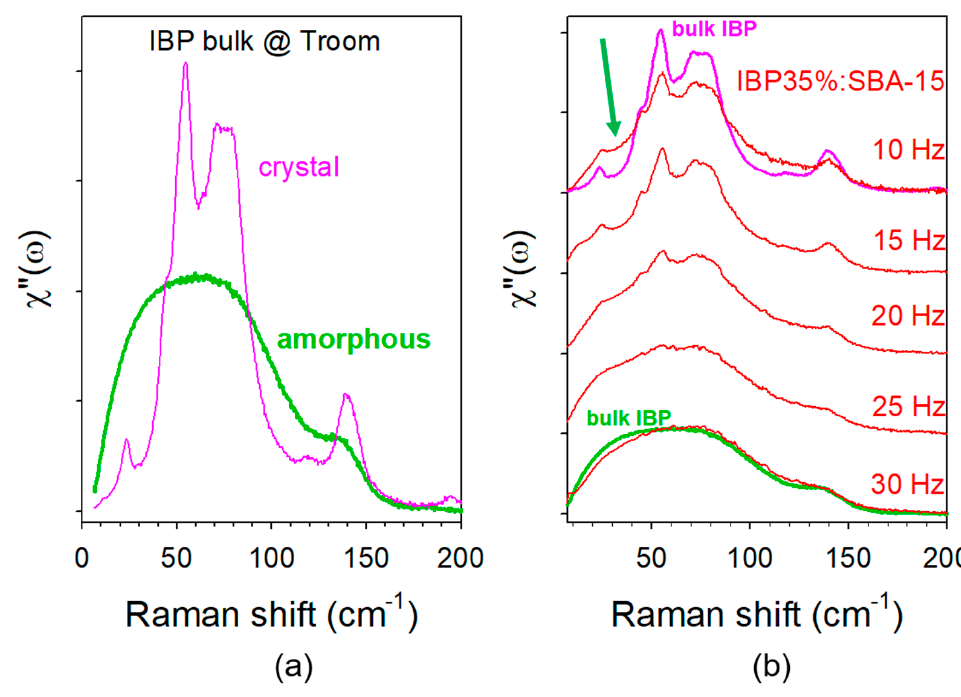
Figure 3. Raman susceptibility spectra of crystalline, partially crystalline, and amorphous ibuprofen; ( a ) spectra of the crystalline and amorphous bulk forms; ( b ) spectra of confined ibuprofen in SBA-15 using MAL at various frequencies: the arrow highlights the intensity excess in the very low-frequency range, reflecting the presence of amorphous IBP .